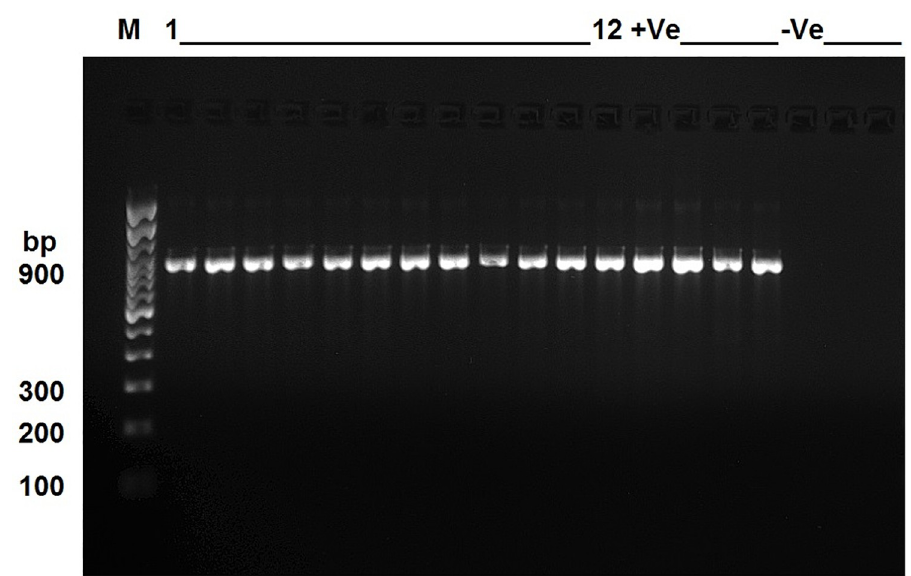
Fig 3. Gel image of PCR amplified 16S rRNA gene (partial, ~ 900 bp) for the 12 samples shown in Table 1.